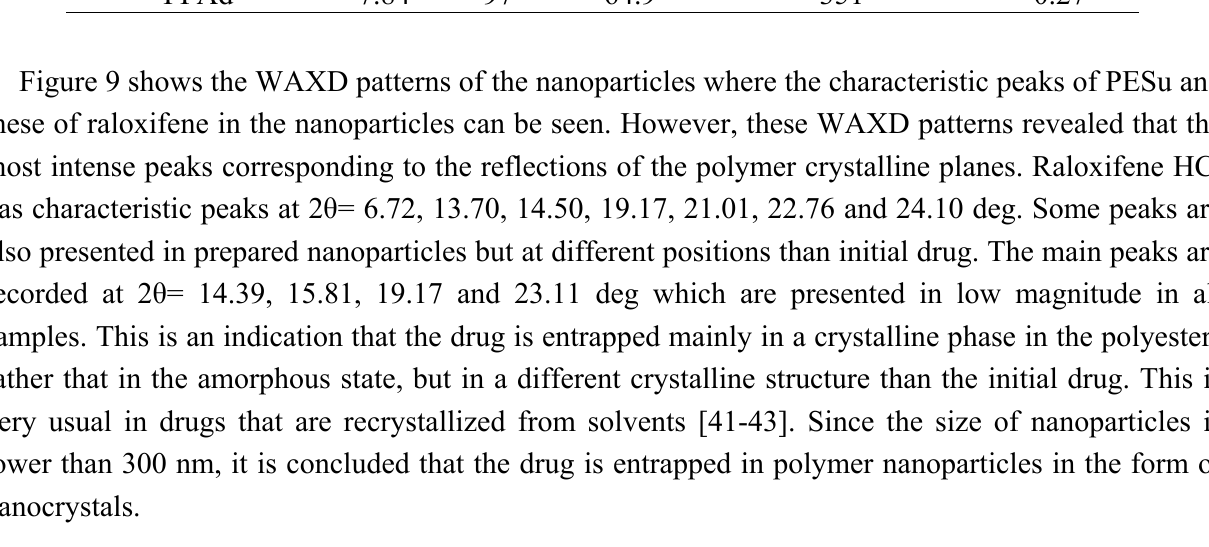
Figure 9. Comparative WAXD patterns of Raloxifene HCl and the drug loaded